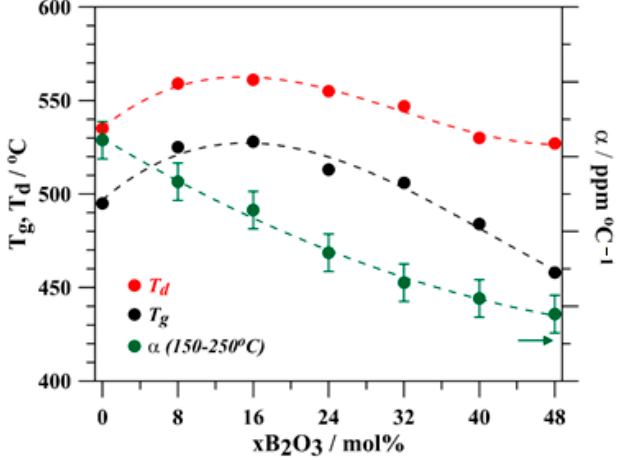
Figure 3. Glass transition temperature, T g , dilatometric softening temperature, T d , and coefficient of thermal expansion, α , in the glass series (100 − x)[0.4Na 2 O-0.2Nb 2 O 5 -0.4P 2 O 5 ]-xB 2 O 3 . (Dashed lines are only a guide to the eye.).